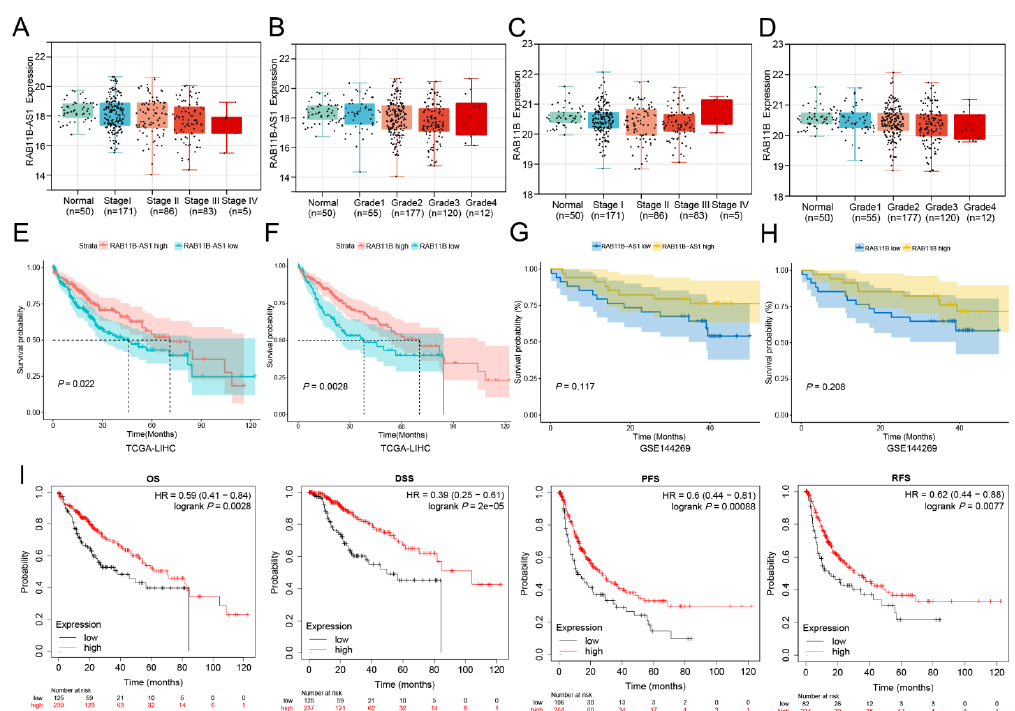
Figure 2. Relationship between lnc-RAB11B-AS1 and RAB11B expression and the prognosis of HCC patients ( A , B ) The different expression status of lnc-RAB11B-AS1 in the histologic grade and clinical stage of HCC. ( C , D ) The change of RAB11B expression in the histologic grade and clinical stage of HCC. ( E , F ) The association between lnc-RAB11B-AS1 and RAB11B expression and OS in TCGA database. ( G , H ) The correlation between the expression of lnc-RAB11B-AS1 and RAB11B and OS in GSE144269 dataset. ( I ) The relationships between RAB11B expression and OS, RFS, PFS, and DSS of HCC patients in Kaplan-Meier Plotter database. Table 1. Relationship between clinicopathological characteristics and expression of lnc-RAB11B- AS1 .